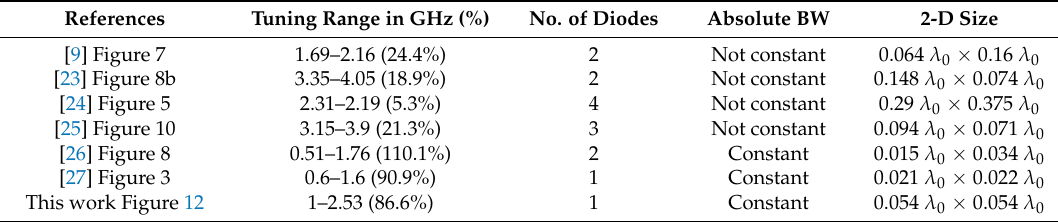
Figure 15. Measured ( a ) | S 21 | (dB) and ( b ) | S 11 | (dB) of the second-order tunable CPW band-stop filter under different DC bias. Table 1. Comparison of different tunable CPW band-stop filters.